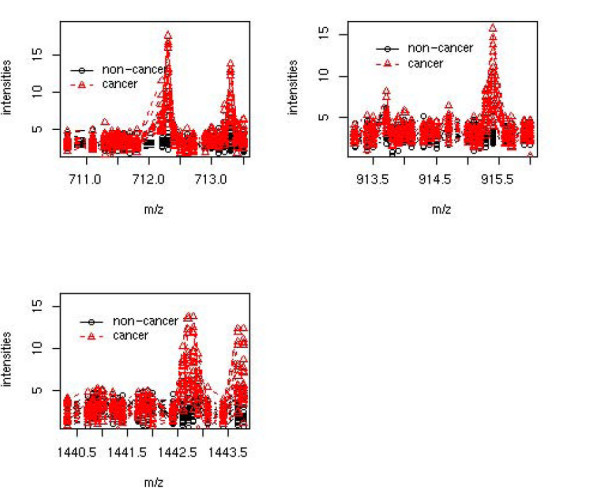
Three m/z value area to distinguish cancer from non-cancer. Plot of m/z values areas which can discriminate ovarian cancer (red) from non-cancer (black). The upper left plot is for m/z value 712.28; the upper right plot is for m/z 915.38 and lower plot is for m/z 1442.72. The m/z values are visually larger for cancer patients. For quantification purpose, simple descriptive statistics for the three areas are reported as the following: for m/z value 712.28, mean(standard deviation) of non-cancer samples are 4.506(3.181) and cancer samples are 10.633(3.615). The FDR-adjusted p-value for the comparison is 7.827e-07; for m/z value 915.38, mean(standard deviation) of non-cancer samples are 3.667(2.614) comparing to cancer samples 8.443(3.307). This results in FDR-adjusted p-value of 7.642e-06. The higher m/z 1442.72 has 2.958(2.435) for non-cancer samples of mean(standard deviation), while cancer samples are 7.275(3.1). The FDR-adjusted p-value for high mass area is 1.841e-05.